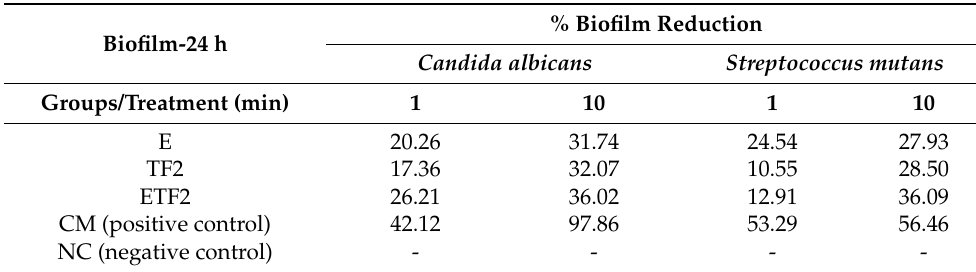
Table 3. Percentage of reduction in Candida albicans and Streptococcus mutans dual-biofilms formed for 24 h and treated for 1 or 10 min.